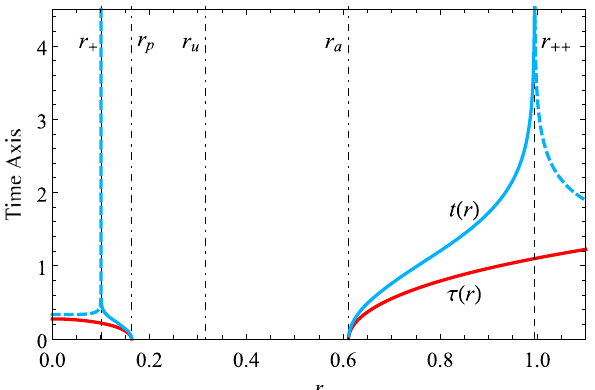
Fig. 12 The radial behavior of the proper and coordinate times in the two kinds of frontal scattering, plotted for Q = 0 . 2, λ = 1 and E 2 = 0 . 6. After being scattered from r a (or r p ), the comoving observers see a horizon crossing. This is while a distant observer never observe this (frozen falling particles)